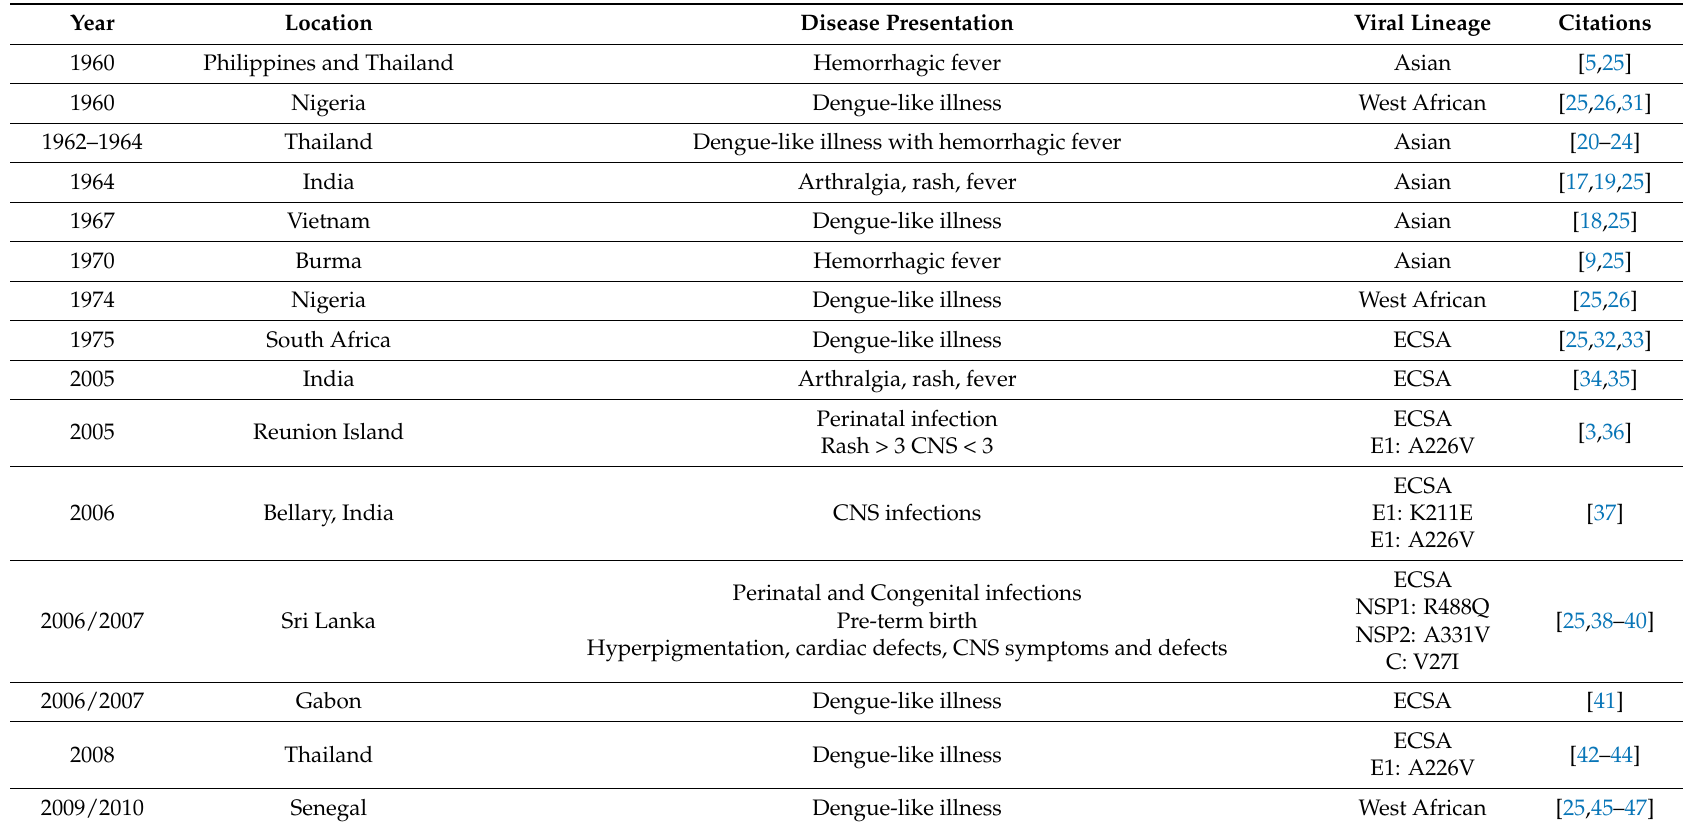
Table 1. Symptoms of chikungunya fever are associated with new viral genotypes. Chikungunya outbreaks with descriptions of chikungunya fever in children, infants, and neonates are matched with the genotype circulating in the region at the time the outbreak was reported. The contribution of these mutations to disease has not been